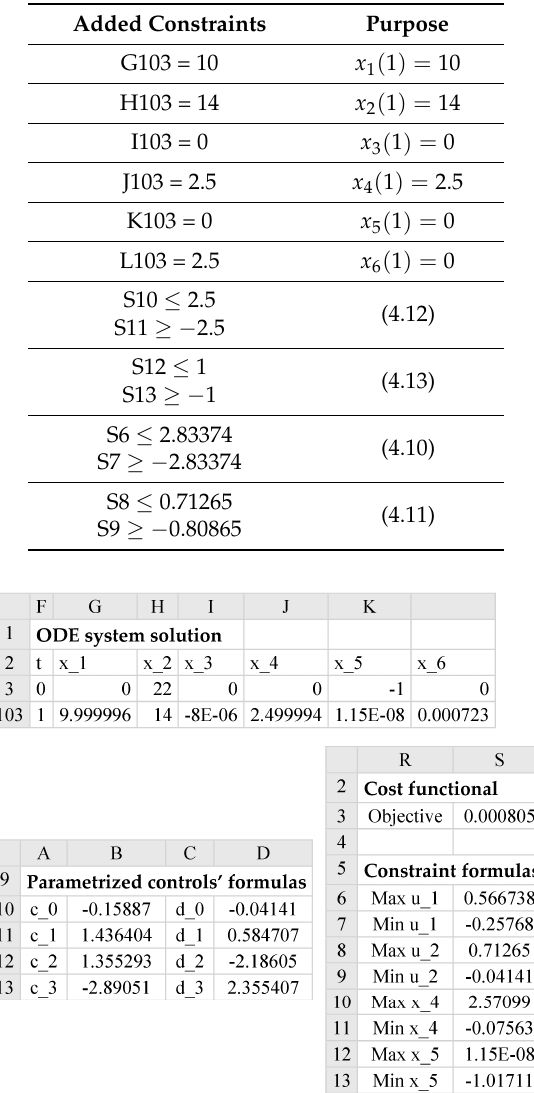
Table 4. List of constraints added to the NLP Solver for optimal control problem (17)–(29) and their corresponding equations. The bound constraints were defined using aid formulas listed in Table 3.